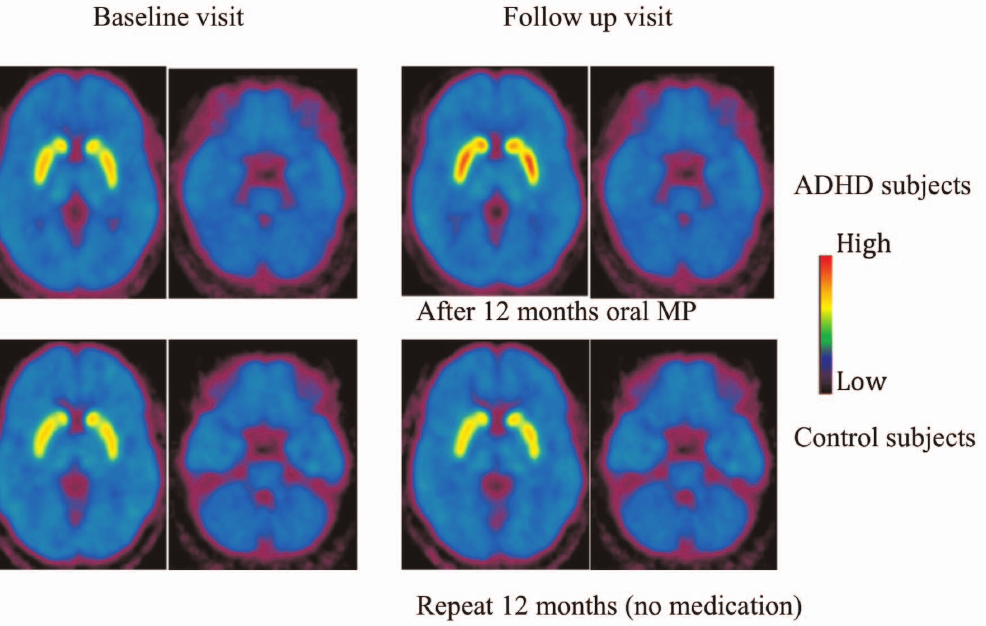
Figure 1. Averaged dopamine transporter availability images. Averaged dopamine transporter availability images of ADHD (n=18) and control (n=11) subjects prior to and after 12 months oral MP treatment as well as baseline and 12 follow up scans of control subjects. The images are scaled with respect to the maximum value (distribution volume ratio) obtained on the ADHD subjects at follow up visit and presented using the rainbow scale. Red represents the highest value and dark violet represents the lowest value.